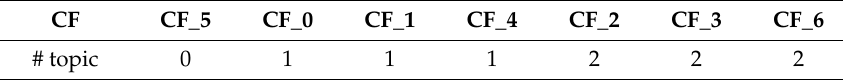
Table 10. Results of the Final Version of the Labels of the CF’s Semantic Clusters.